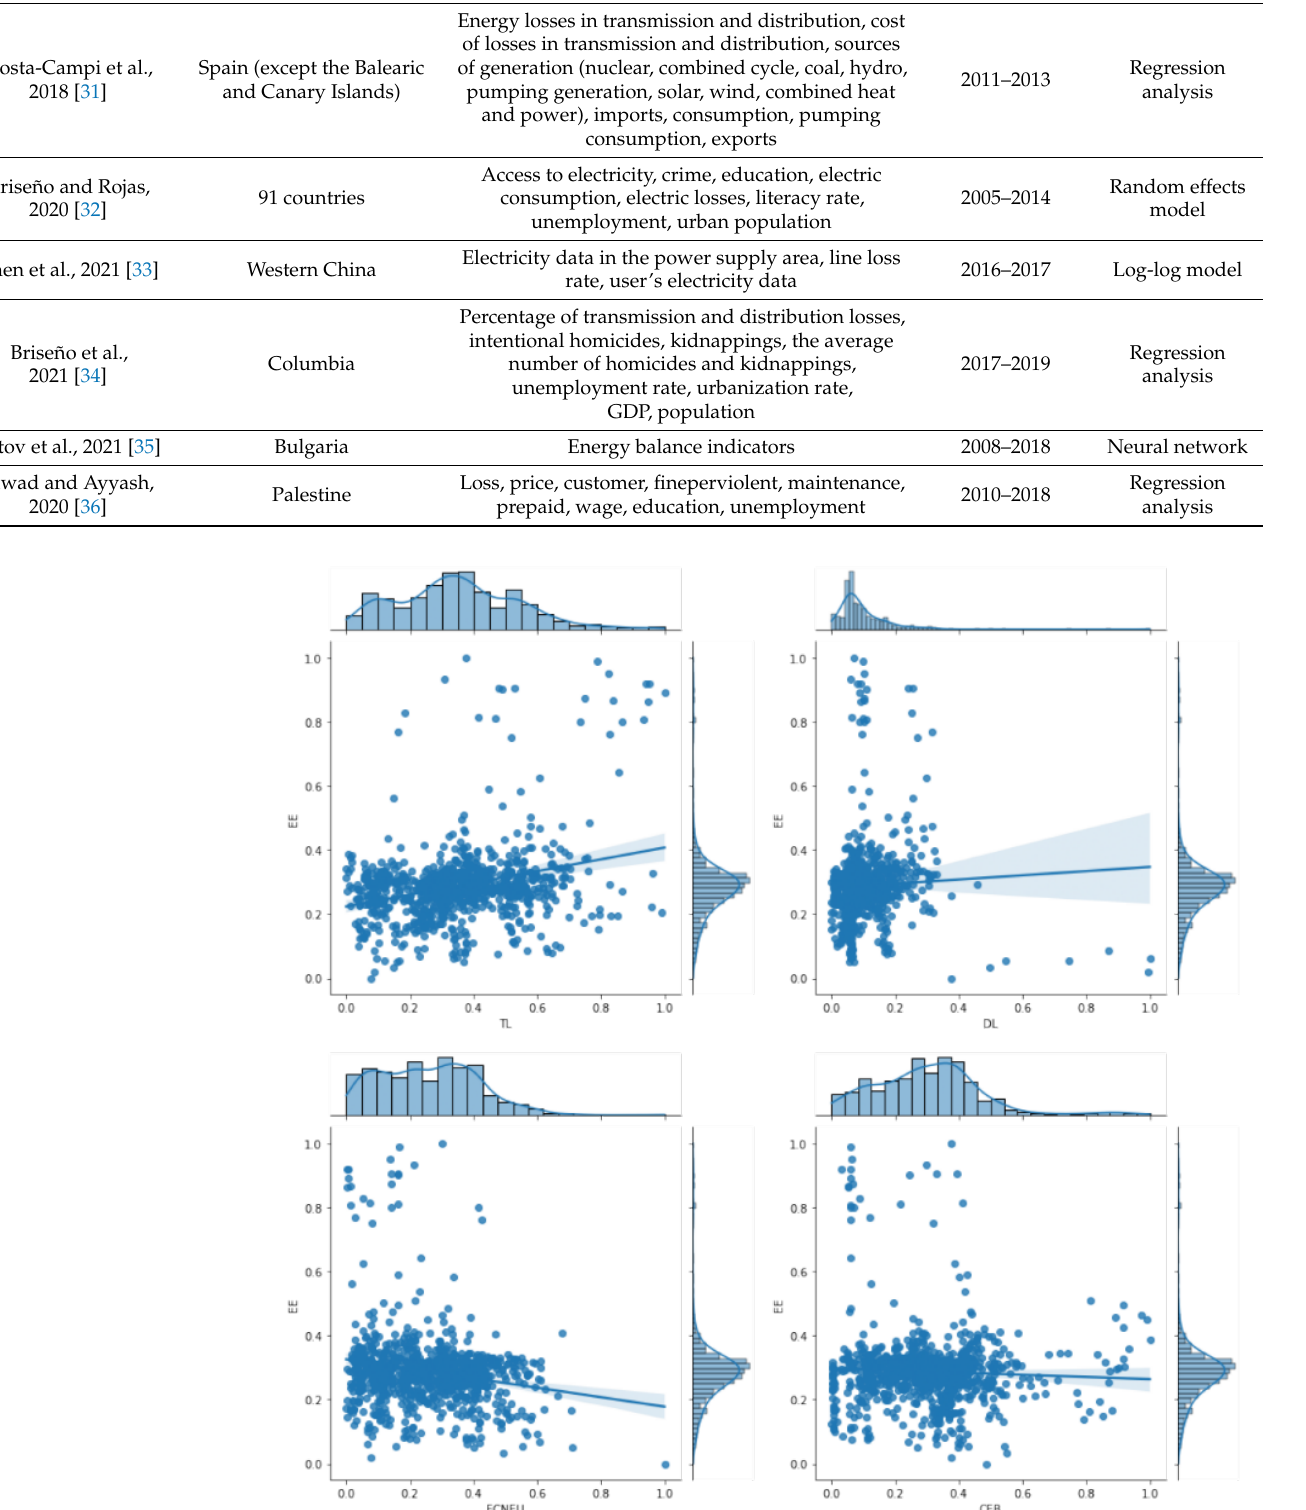
Table 2. Statistical description of the variables.